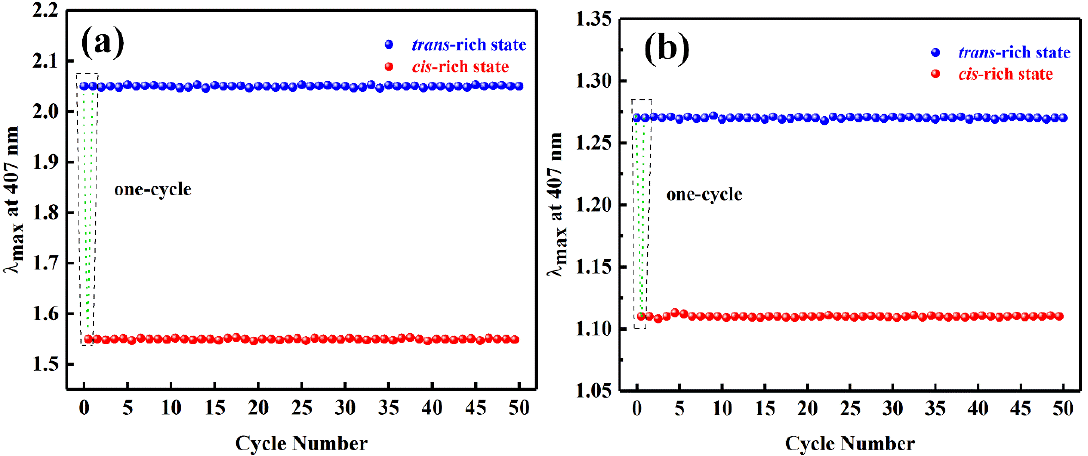
Figure 4. Stability performance of ( a ) Azo F and ( b ) Azo F –rGO-3 for 50 times. The photothermal storage capacity of Azo F and Azo F -rGO was investigated through DSC [7]. All objects were stable between 10–140 ◦ C based on TGA. Azo F and Azo F - rGO released significant heat under the first round of heating stimulation, but no heat that the research subjects have released all the energy stored through the configuration start to release the stored energy after 100 ◦ C, while this kind of heat storage material can start energy output at 35 ◦ C, which is a milestone in achieving fast energy output at lower temperatures